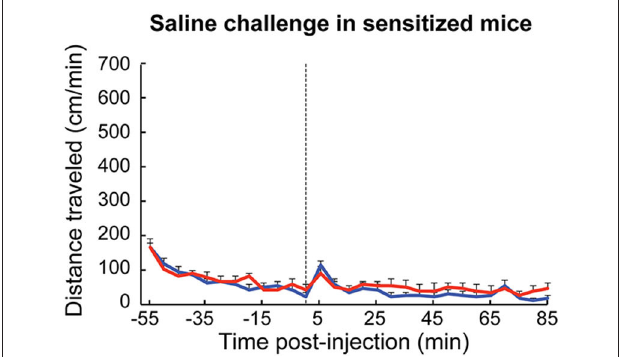
FIGURE 6 | Responses of amphetamine-sensitized mice to saline injection were equivalent between genotypes . Wildtype (blue, n = 6) and transgenic (red, n = 6) mice that were previously treated with repeated D-amphetamine (7 mg/kg) injections showed similar sensitized locomotor responses to saline injection (dotted